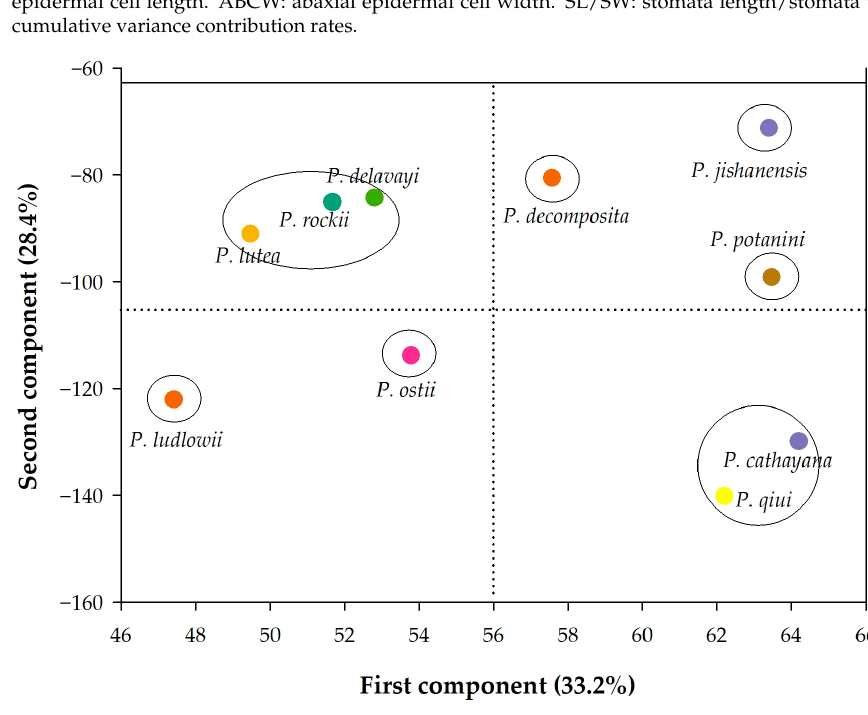
Figure 7. Scatter plot based on the first component and the second component.